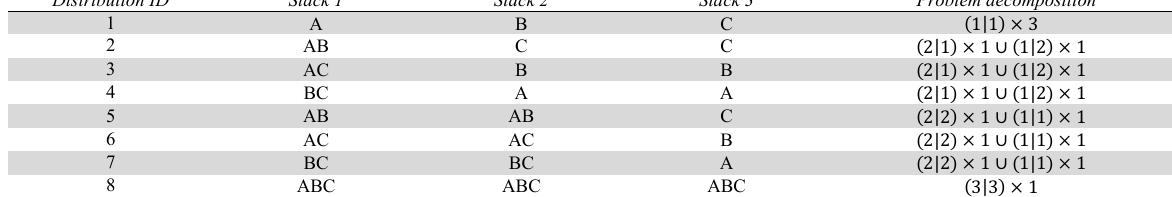
Considered slabs’ distributions and deriving problem decomposition Distribution ID Stack 1 Stack 2 Stack 3 Problem decomposition 1